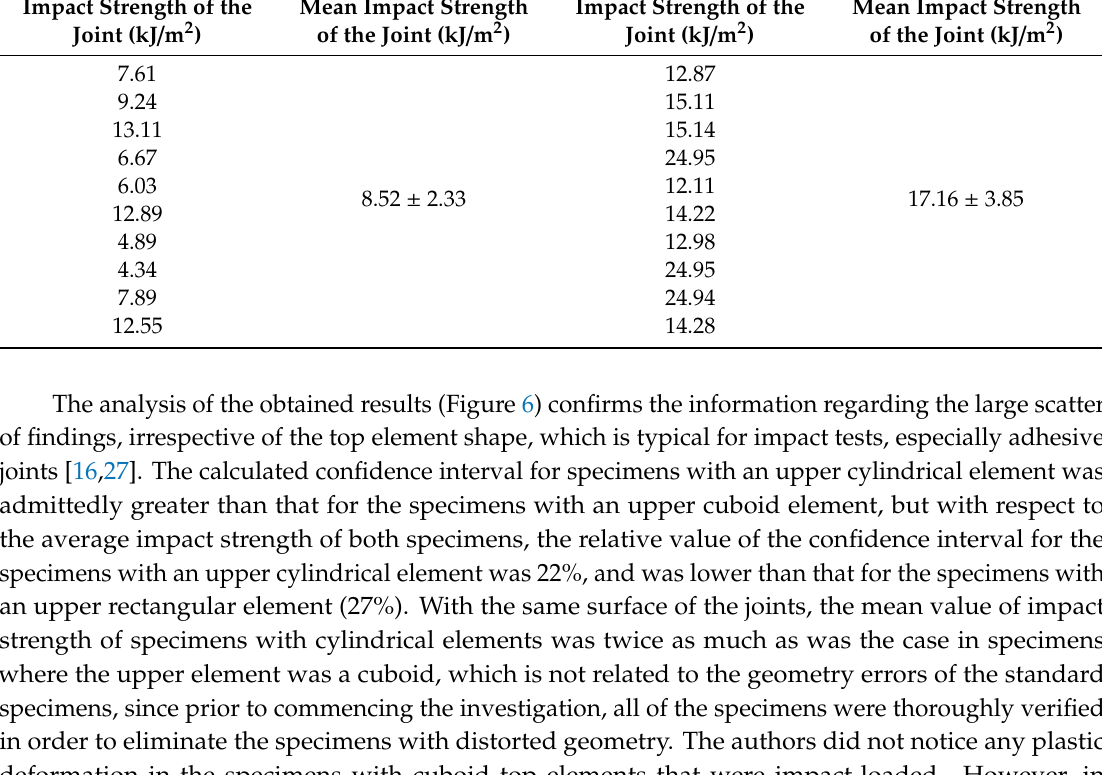
Table 1. The impact test results for block specimens (the mean impact strength is given with the calculated confidence intervals for a 95% level of